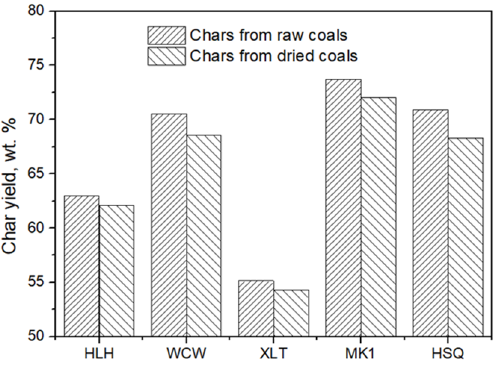
Figure 6. A comparison of the char yield of the pyrolytic char from raw coal and dried coal.